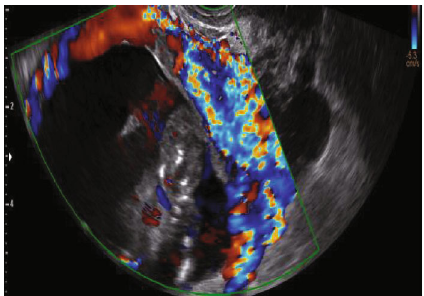
Figure 1: Ultrasound imaging with radiology report noting thickening of the endometrium at the fundus. The gestational sac appears at the lower segment with bulging towards the bladder. In the uterus, there is signi fi cant vascularity surrounding the gestational sac and there appears to be very little myometrium.